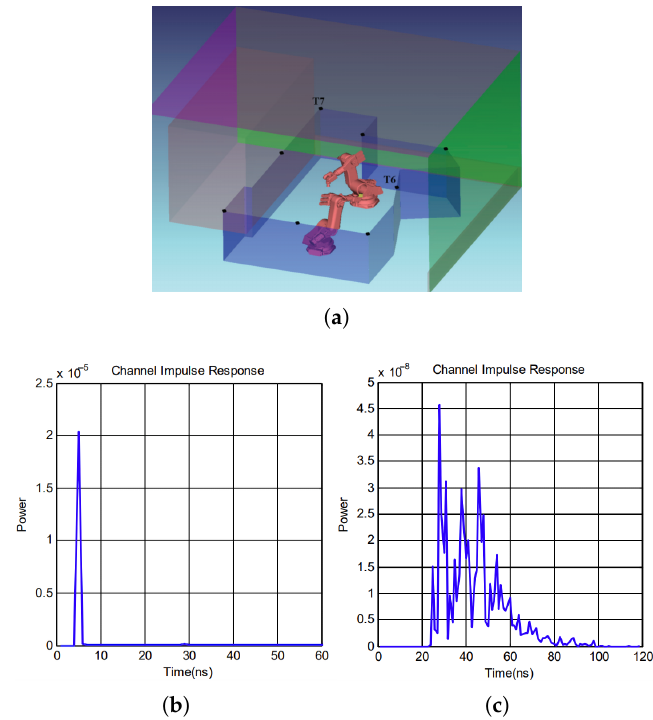
Figure 4. The evaluated manufacturing cell in [21]: ( a ) Manufacturing cell scenario; ( b ) channel impulse response for T6; and ( c ) channel impulse response for T7. The figures were adopted from